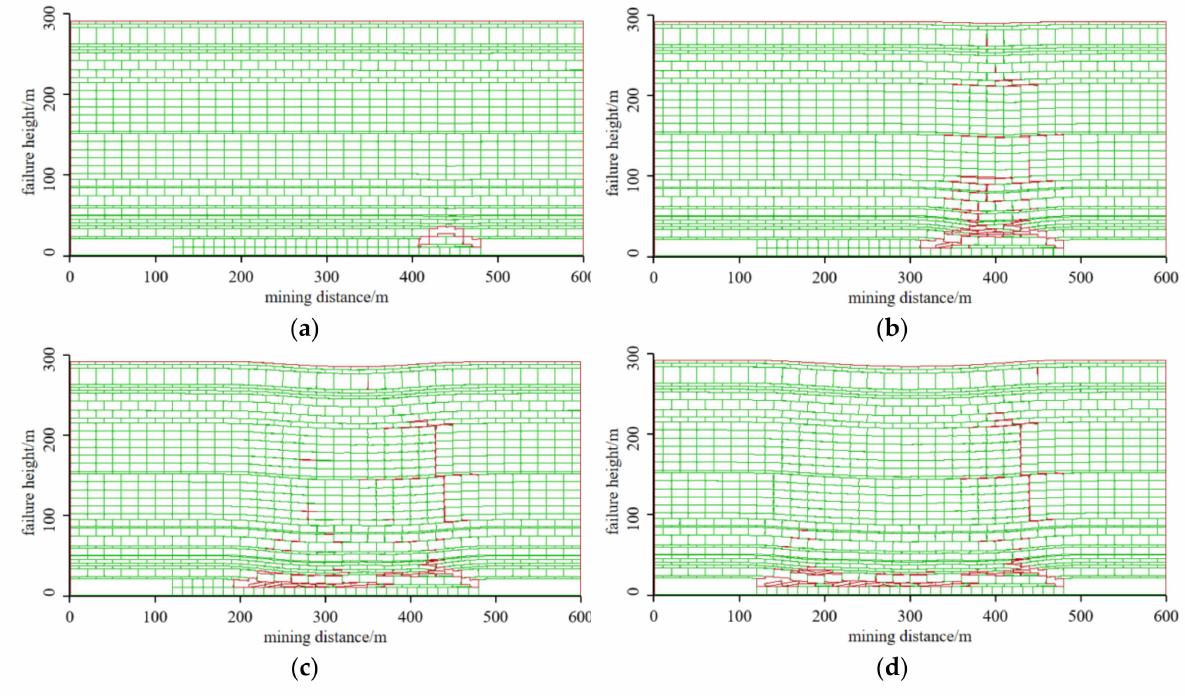
Figure 8. Fracture distribution of overburden under the extraction of the first slice with the working face advancing to: ( a ) 72 m (the first slice); ( b ) 168 m (the second slice); ( c ) 288 m (the first slice); ( d ) 360 m (the end of the extraction of the first